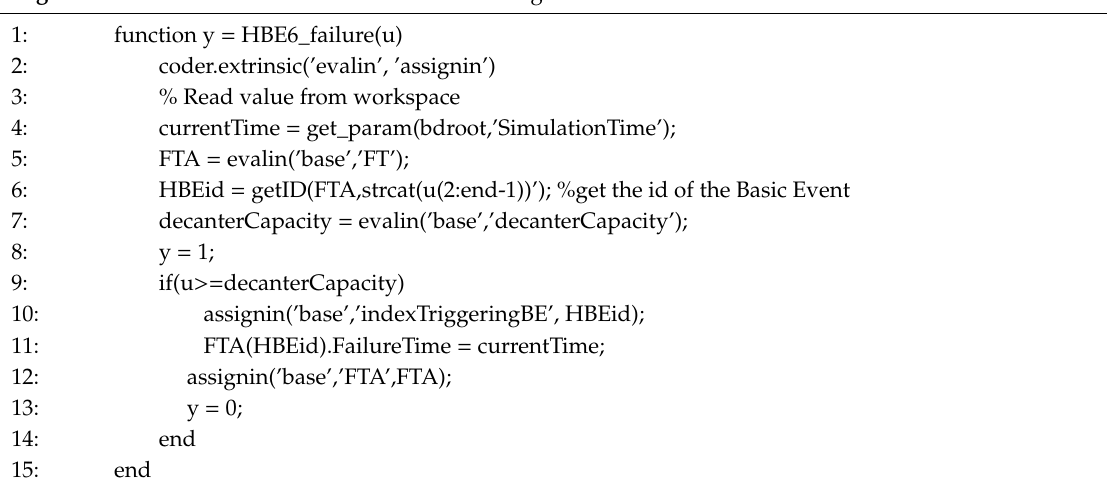
Figure 7. The Simulink implementation of the hybrid basic event HBE6. Algorithm 2 Code for the definition of the failure logic of the HBE6.